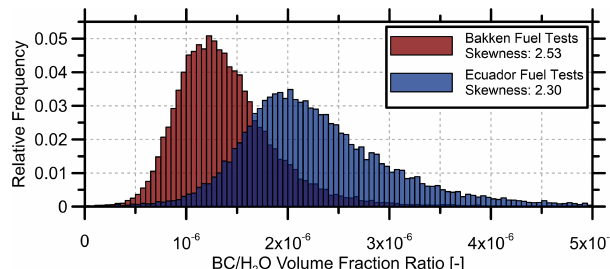
Figure 8. Aggregated BC / H 2 O ratio distributions for the two fuel types